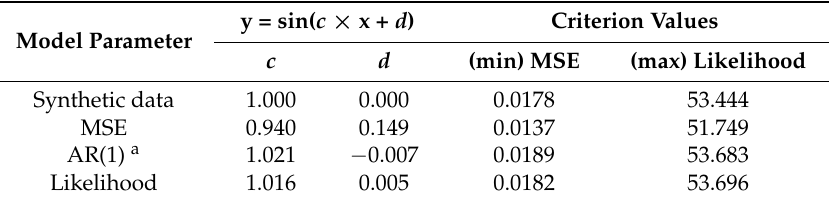
Table 2. Optimized results of model parameter values and corresponding criterion values of MSE and Likelihood.